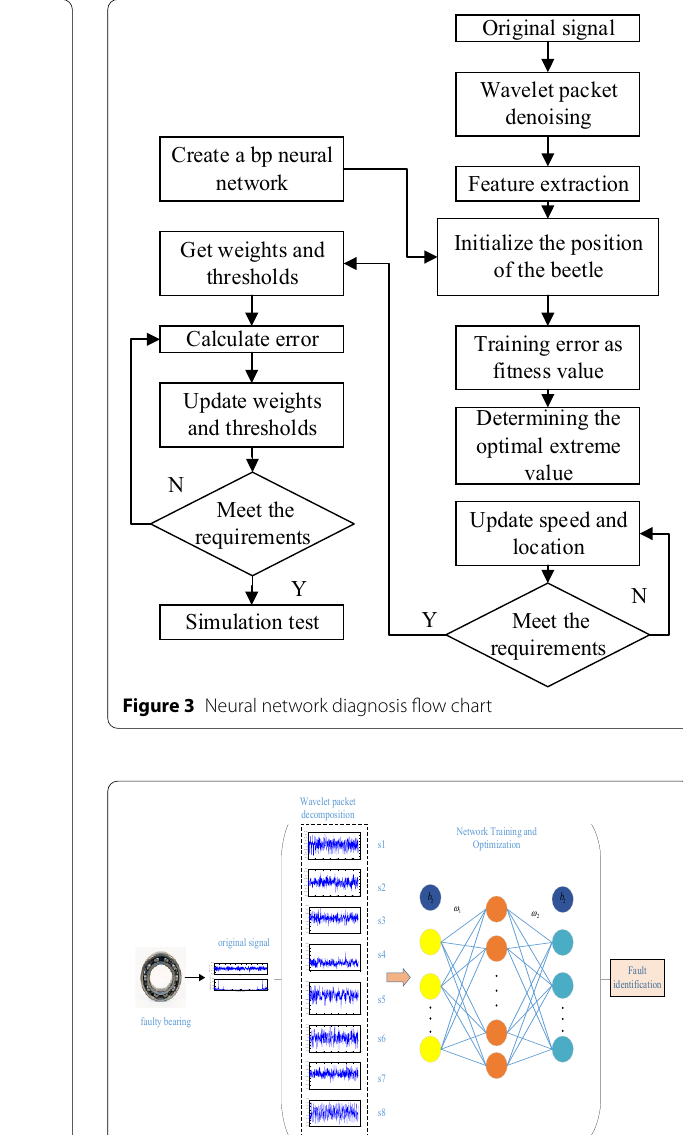
Figure 4 Bearing diagnosis